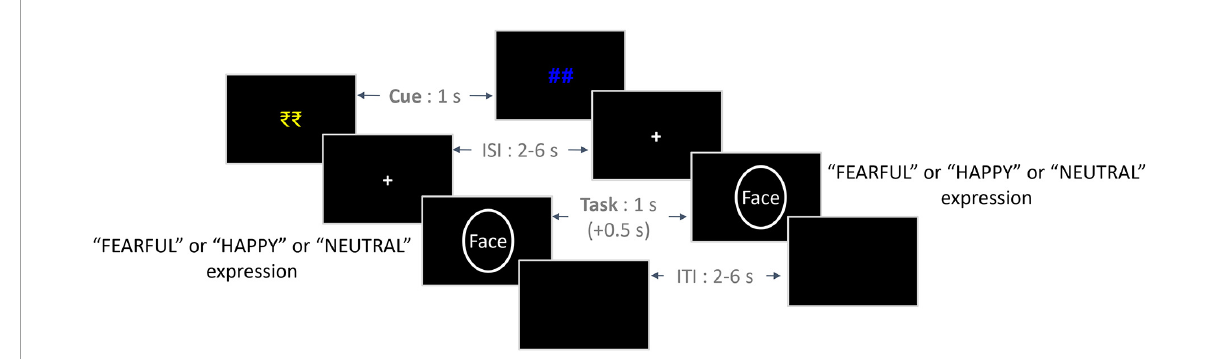
FIGURE1 Trial structure of the experimental paradigm. On the left is an exemplar trial from the Reward condition, and on the right is an exemplar trial from the No-reward condition. The initial reward/no-reward cues (1 s) were followed by a jittered ISI (2–6 s), which was followed by a face stimulus (1 s) from either of the three emotion conditions. Participants were given a response window of 1.5 s from the onset of the face stimulus, which included an additional 0.5 s post offset (indicated by +0.5 s). Finally, a jittered ITI (2–6 s) was employed between trials. ISI, inter-stimulus interval; ITI, inter-trial